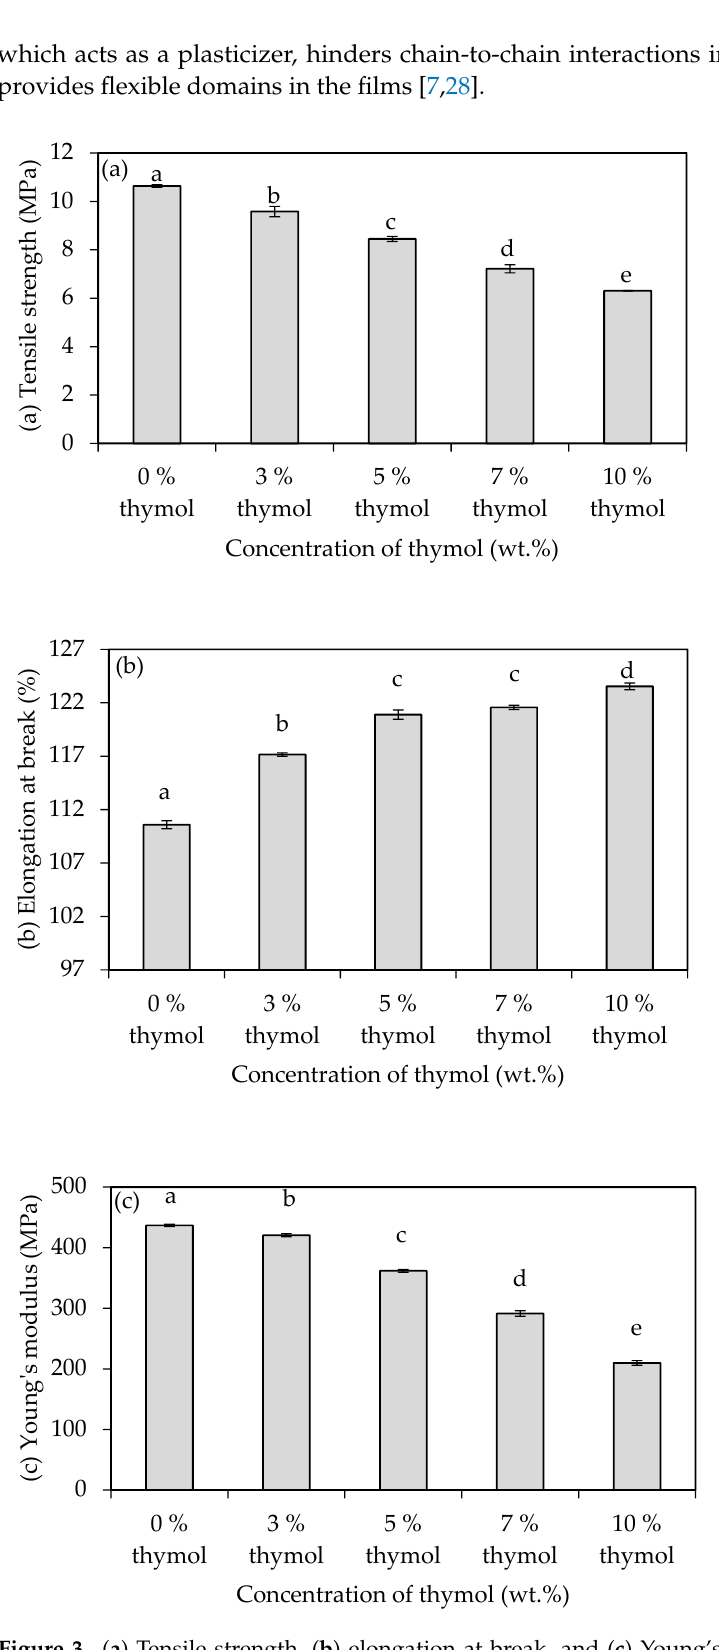
Figure 3. ( a ) Tensile strength, ( b ) elongation at break, and ( c ) Young’s modulus of starch/CNF bionanocomposite films incorporated with different concentrations of thymol. Different letters in the same graph indicate a statistically significant difference ( p < 0.05).